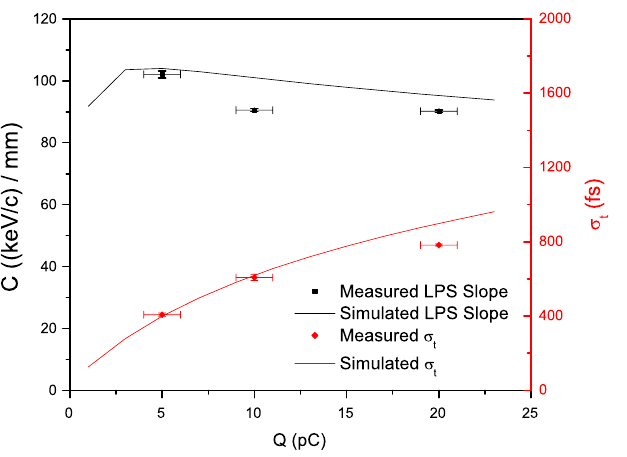
FIG. 5. (Color) A scan of the chirp ( C ) (left axis, black) and (cid:8) t (right axis, red) versus rf gun phase. The measured values (points) are compared to simulations performed with general particle tracer. The scan was performed with a 20 pC electron beam with an initial spot size at the cathode, (cid:8) l of 400 (cid:1) m .